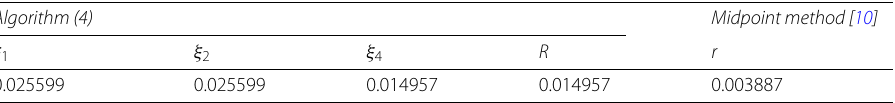
Table 5 Parameters for example 5